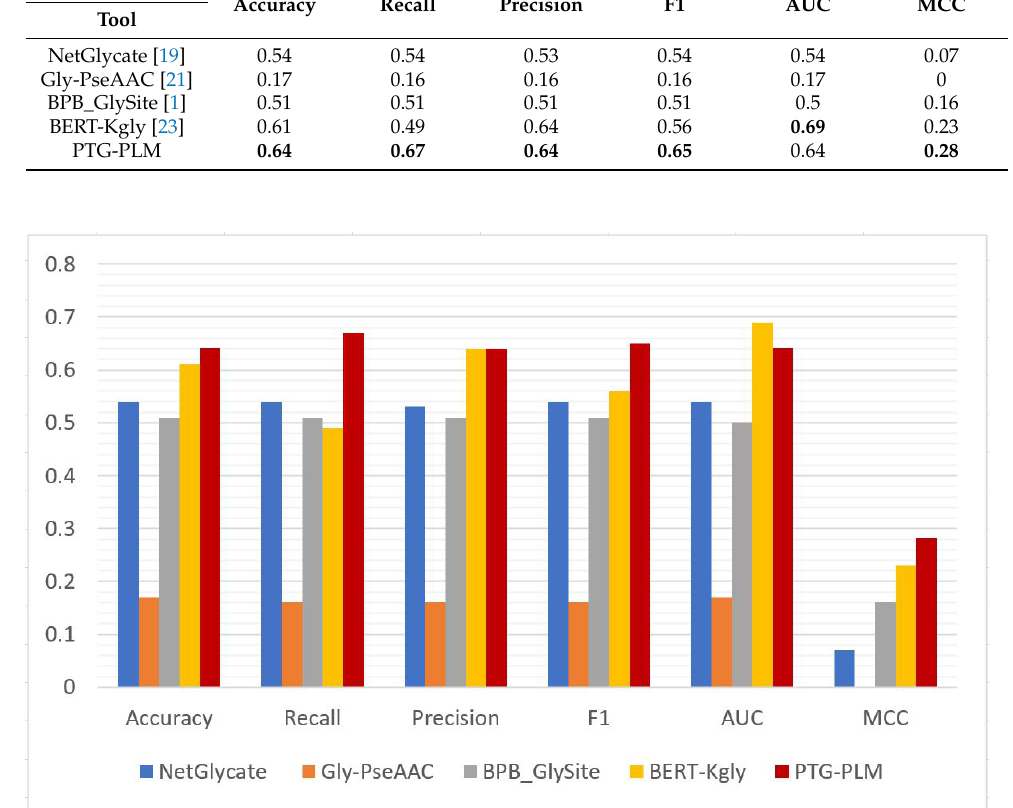
Figure 8. Chart for the performance of PTG-PLM and the existing tools for Kgly site